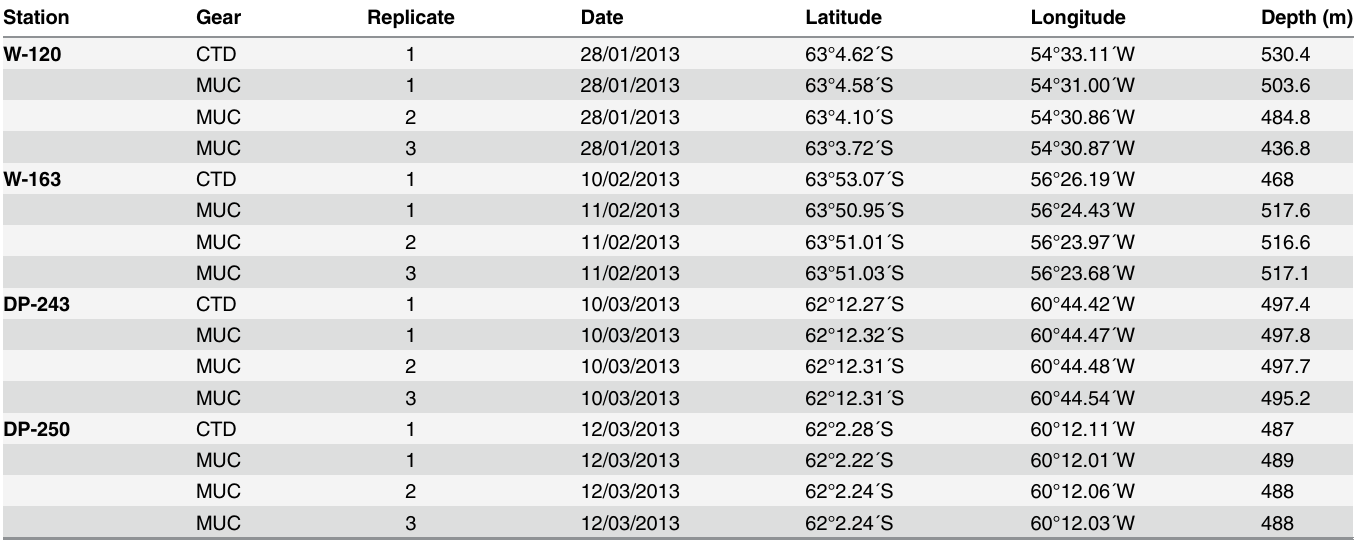
Table 1. Details of the four sampling areas: each station was sampled once with a CTD, followed by three replicate MUC deployments.